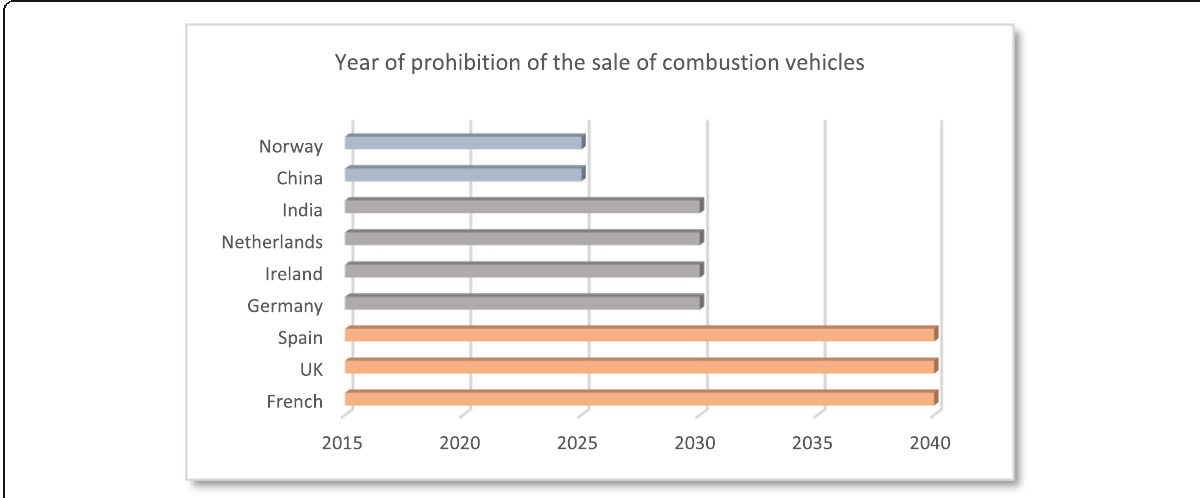
Fig. 20 Year of the prohibition of the sale of combustion vehicles